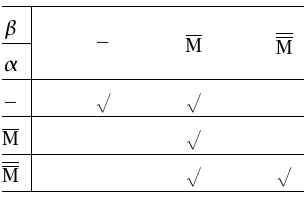
√ Table 1.6 . The mark indicates that for the corresponding case if (X,S) is A (α) distal, then (X,S) is A (β)